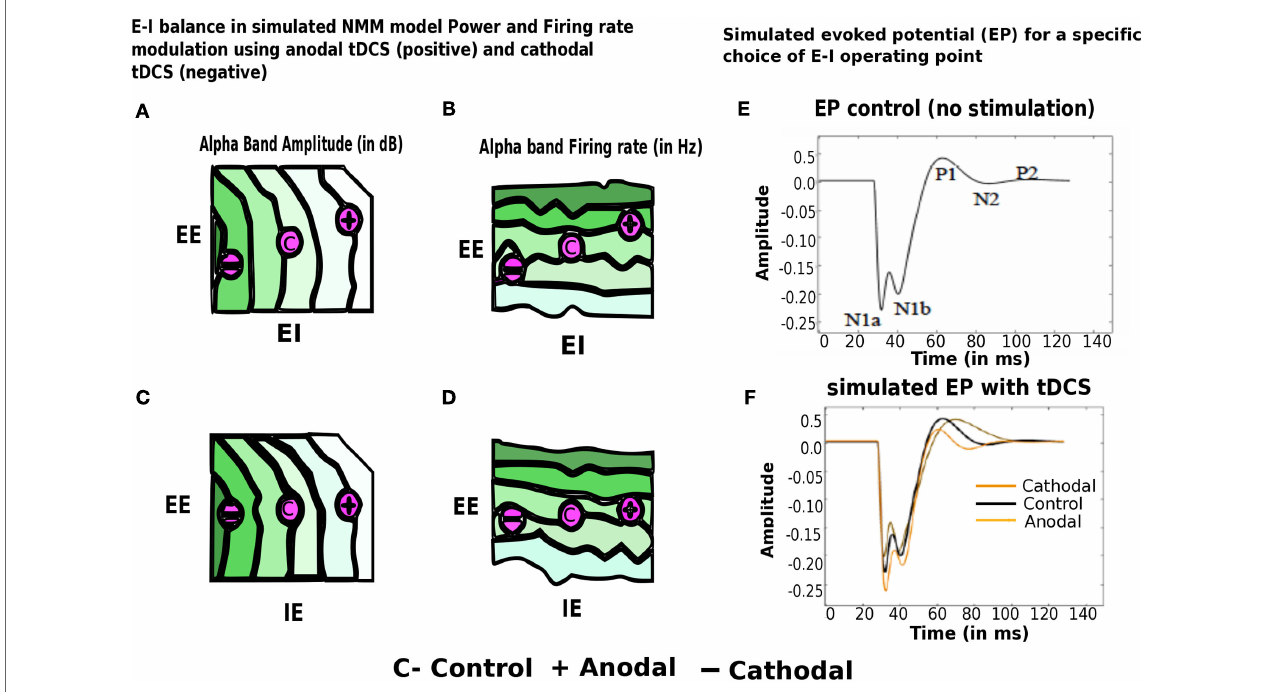
FiGUre 7 | Modulation of alpha band (brain state) amplitude, firing rate, ep with anodal and cathodal tdCs and ee, ei, ie synaptic parameters . In (a–d) EI or IE synapses strongly modulated alpha band amplitude, power (10– 12 Hz) (highest values of amplitude, firing rate is color coded in dark green; lowest values of the same are color coded in white). Population firing rate is more sensitive to changes in EE connections. Points in this parameter space that are consistent with the present experimental observation are indicated with an “C” for control (no stimulation) and “ + ” for anodal (positive) and “ − ” cathodal (negative) electric field stimulation. In (e–F) , we look at the evoked potential (EP) under simulated control conditions (in black no stimulation) and also simulated with cathodal (in dark yellow), anodal electric field (in light yellow), stimulations, respectively [figure adapted and modified from Molaee-Ardekani et al.